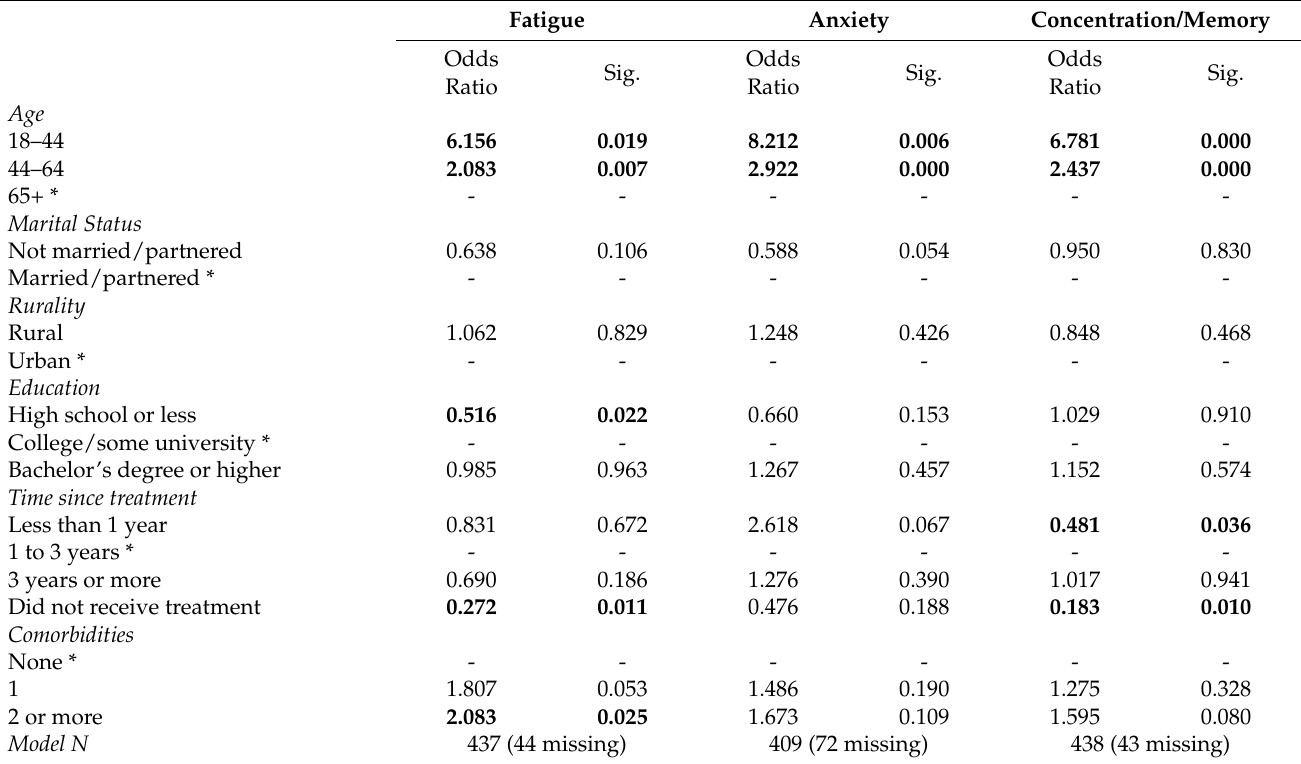
Table 6. Odds ratios from binary logistic regressions for breast patients.